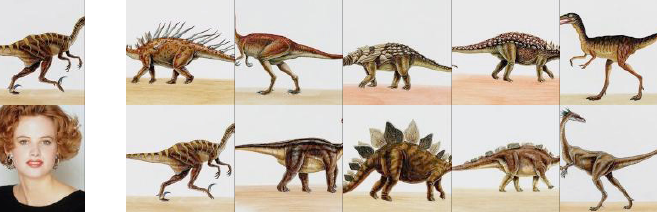
Color only Color and position